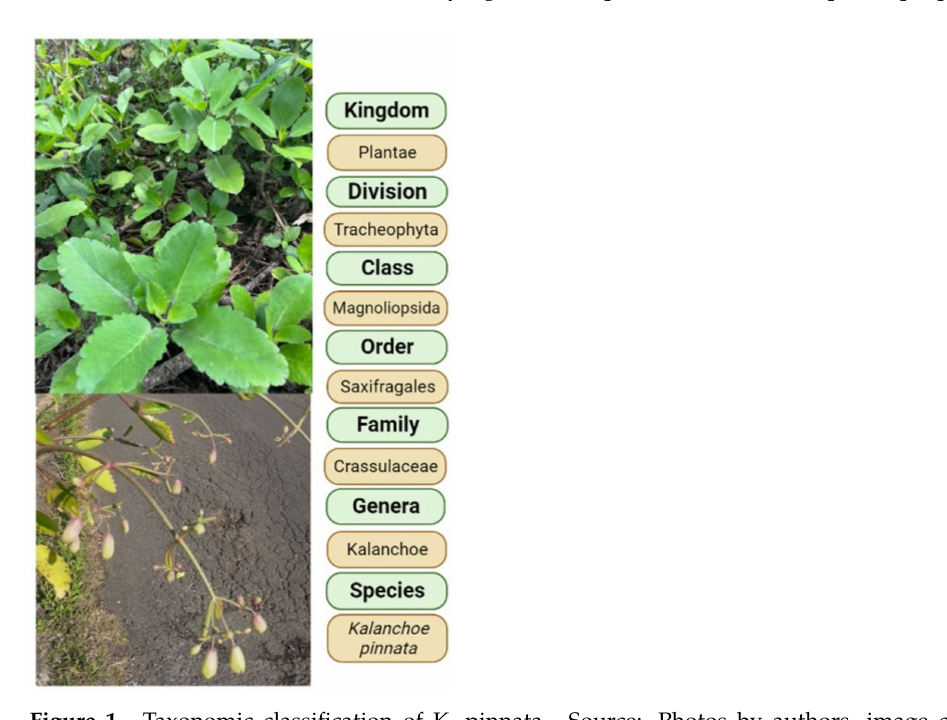
Figure 1. Taxonomic classification of K. pinnata. Source: Photos by authors, image created with